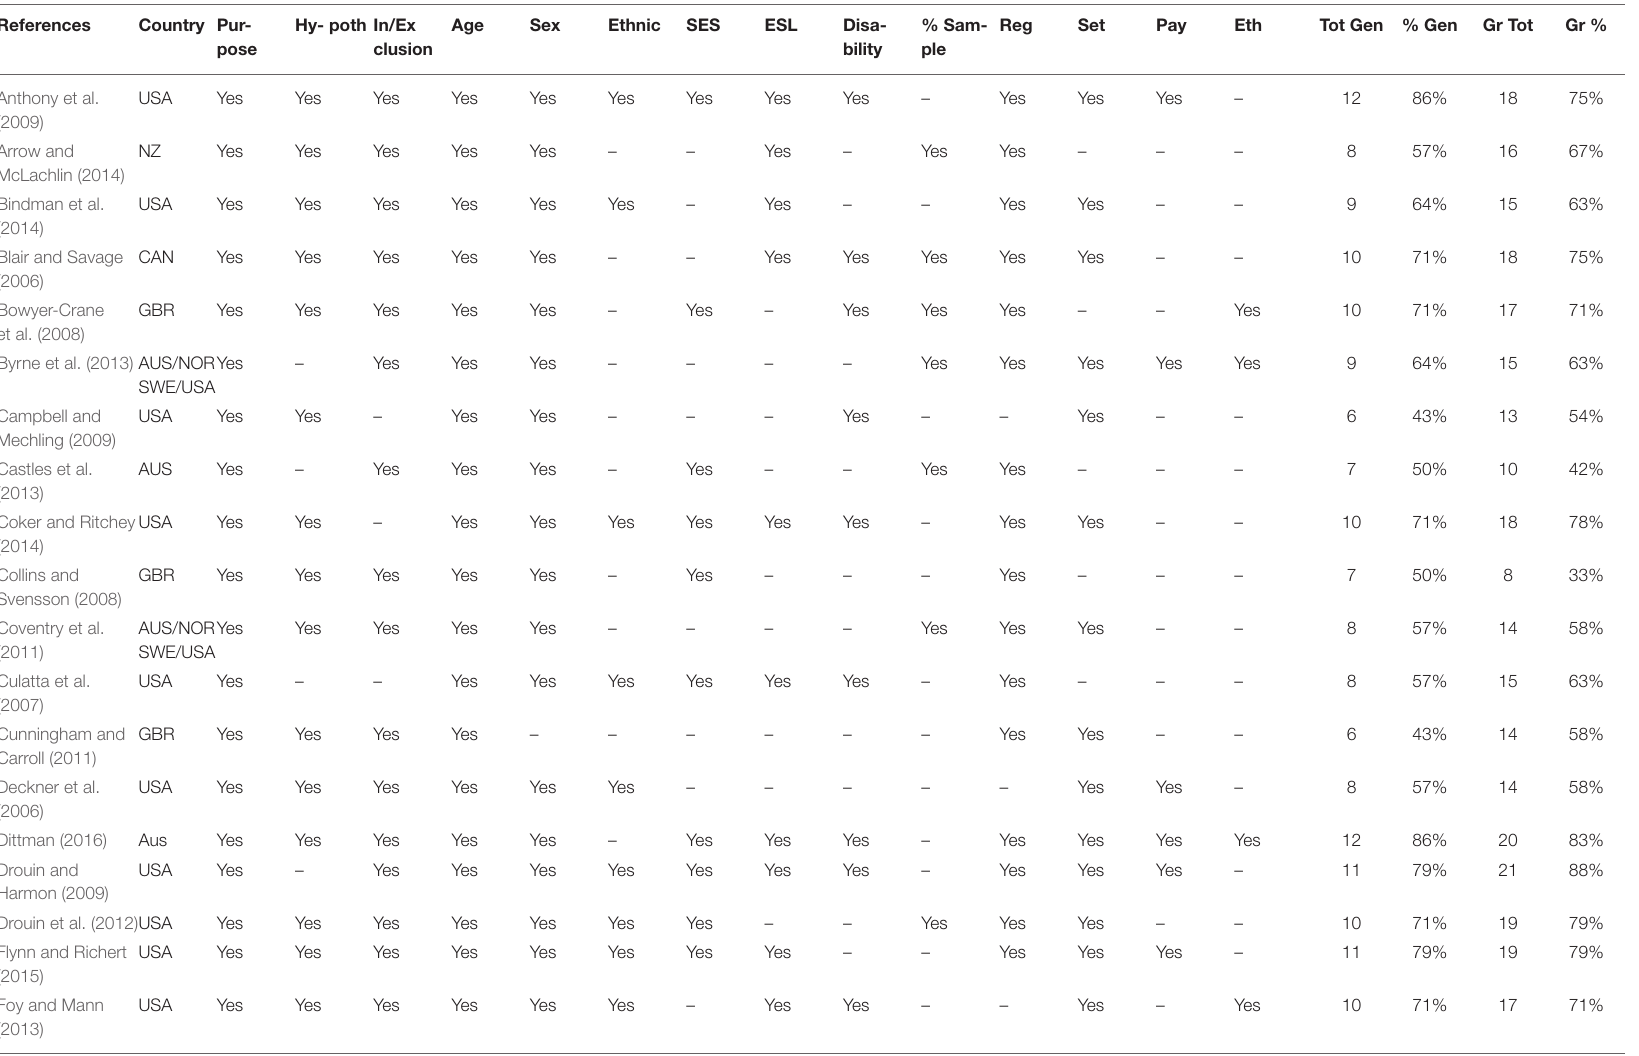
TABLE 2 | Journal information related to general